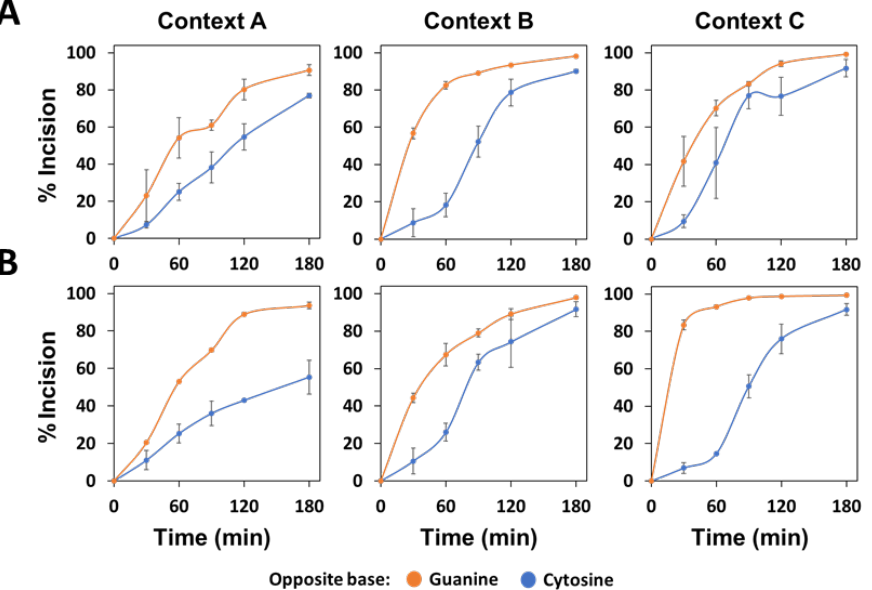
Figure 2. Effect of flanking sequence context and orphan base on the AP endonuclease activity of recombinant Arabidopsis ARP. His-ARP protein (10 nM) was incubated at 37 °C with 40 nM ( A ) or 80 nM ( B ) DNA substrates (contexts A, B or C) containing an AP site opposite guanine (orange) or cytosine (blue). After stabilization with NaBH 4 , reaction products were separated by denaturing PAGE, detected by fluorescence scanning and quantified. Data are the mean and standard error from three independent experiments.